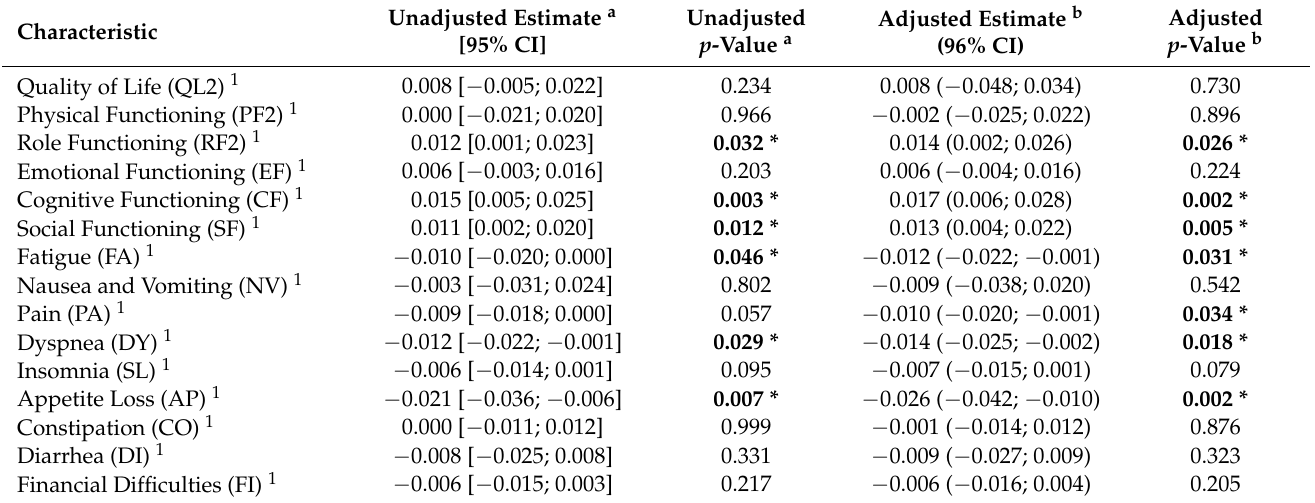
Table A3. Associations between DII and EORTC-QC30 scores adjusted for ‘time since cancer